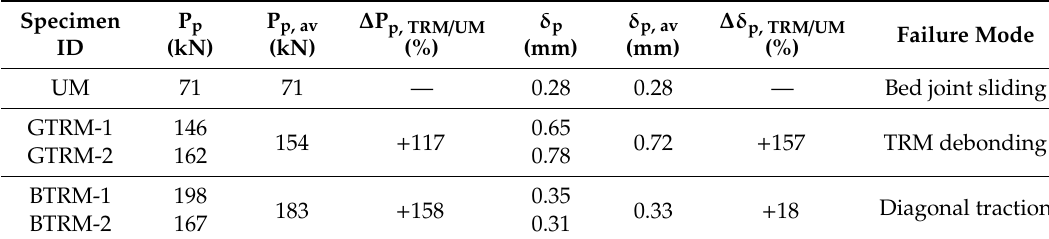
Table 7. Experimental results: peak loads, peak deformations and failure modes.